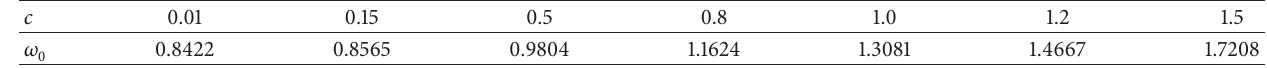
Table 3: Natural frequency 𝜔 0 for different values of the coupling strength parameter.